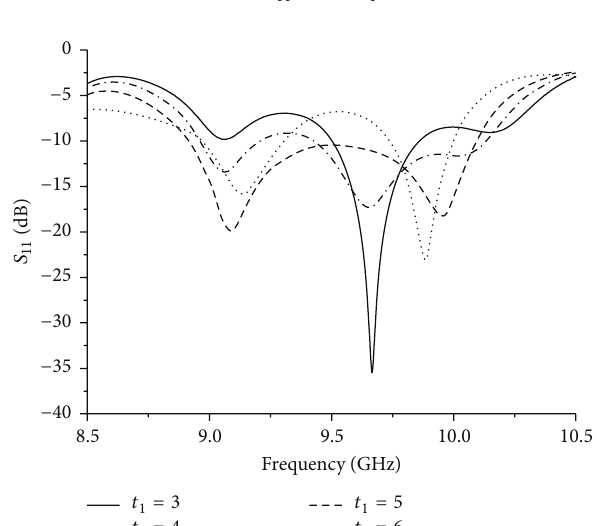
Figure 10: 𝑆 11 when 𝐷 1 varies.